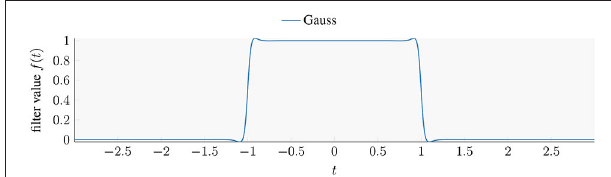
FIGURE 1 | Plot of the Gauss filter obtained by 16-points Gauss-Legendre quadrature of Equation (3), assuming t ∈ R .